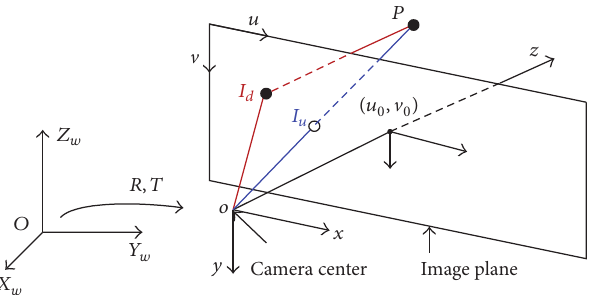
Figure 1: Sketch map of distortion